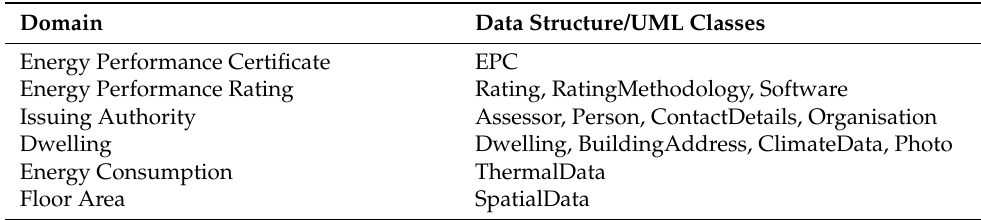
Table 3. EPC details mapped to the modelled data structure.